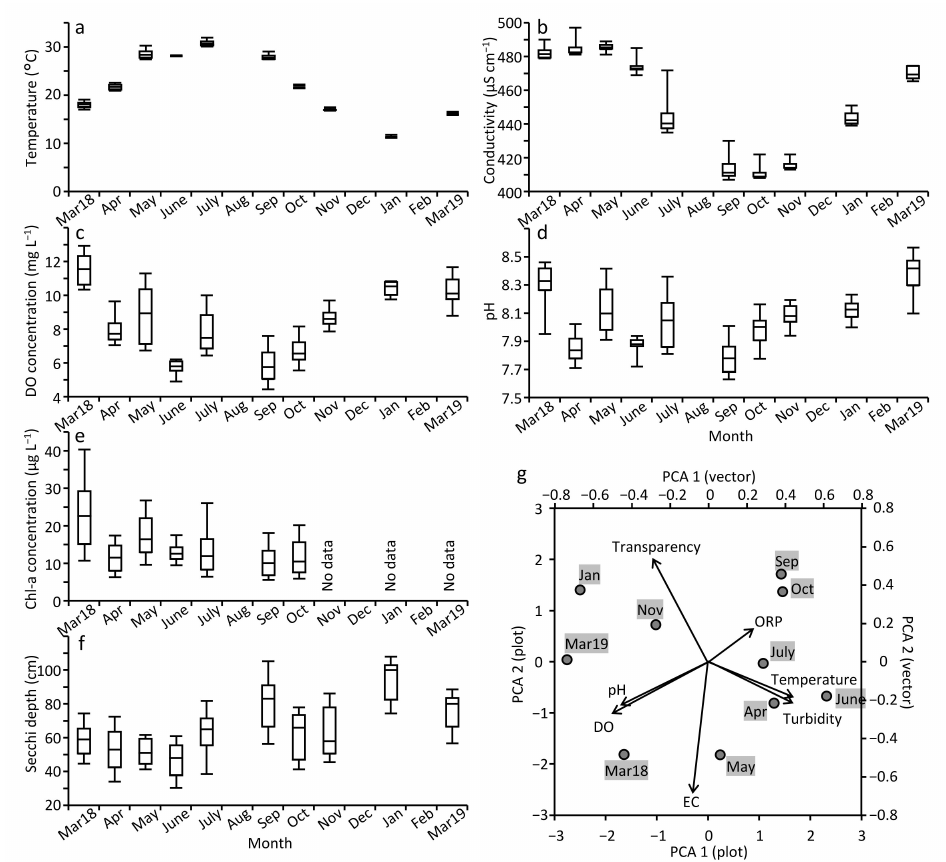
Figure 3. Box plot of water temperature ( a ), electric conductivity ( b ), DO concentration ( c ), pH ( d ), Chl-a concentration ( e ), and transparency ( f ) measured at 18 sites each month, and principal component analysis (PCA) diagram of 7 water quality variables measured over 10 months ( g ) in MA. The box plot shows 10, 25, 50, 75, 90 percentiles of data each